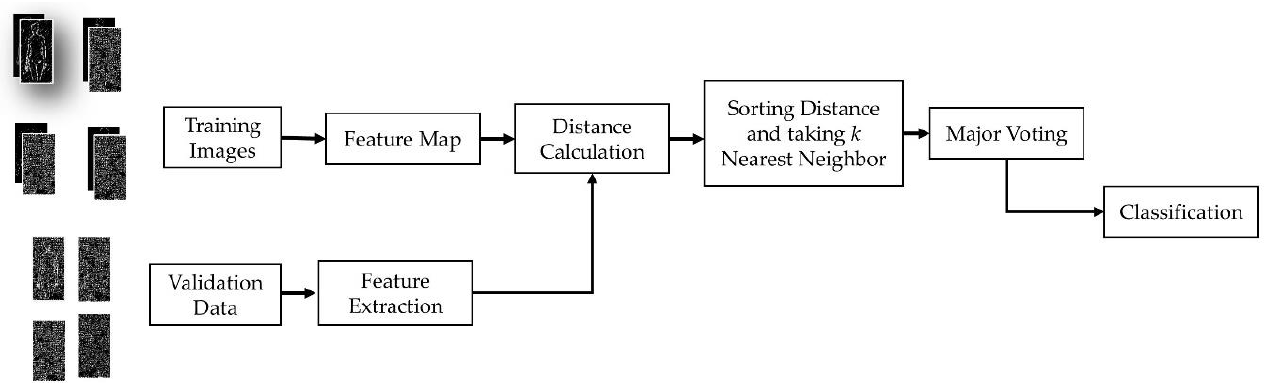
Figure 11. The k- nearest neighbor block diagram for classifying body shape.